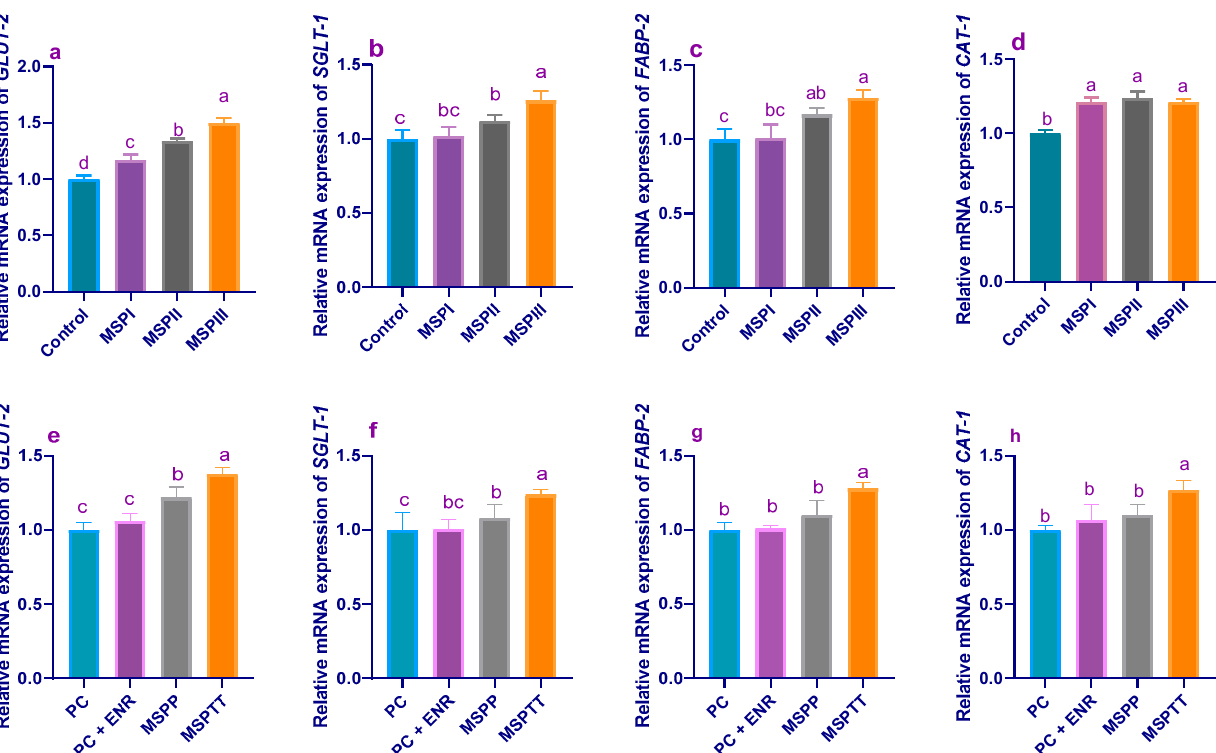
(Figure 6d) genes in rabbits fed MSP over the whole rearing period (MSPTT) and those treated with enrofloxacin. Additionally, the enrofloxacin- and prophylactic and therapeutic MSP (MSPTT) treated groups, followed by prophylactic MSP (MSPP), displayed higher ( p < 0.05) IL-10 (Figure 6e) and TGF- β 1 (Figure 6f) transcriptional levels compared with the experimentally-infected group. Moreover, the most prominent ( p < 0.05) upregulation of in SGLT-1 (Figure 2f), FABP-2 (Figure 2g), and CAT-1 (Figure 2h) gene expression (1.24-, the IFN γ gene (Figure 6g) was detected in rabbits fed MSP during the whole rearing period 1.28-, and 1.27-fold, respectively). (MSPTT) and those treated with enrofloxacin (1.45- and 1.55-fold, respectively).